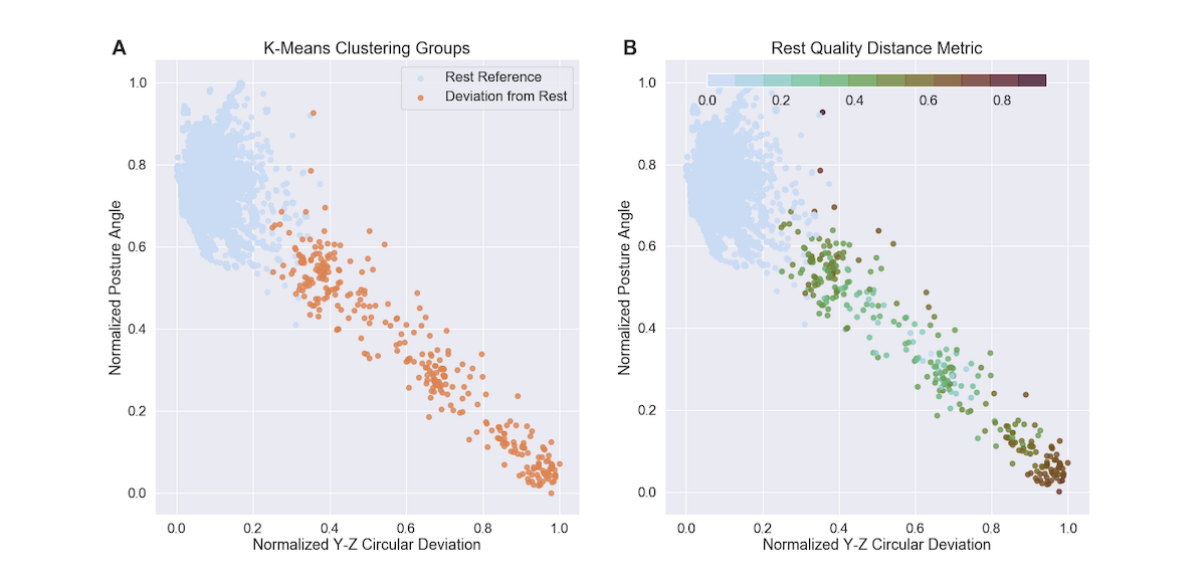
Figure 4. K-means clustering and relative rest quality in a single patient for 2 of the 4 features. (A) K-means clustering diagram plotted across 2 dimensions representing 2 of the 4 features in the clustering algorithm. All data points for each patient were classified using 2 clusters defined as the rest reference cluster (in blue) and the deviation from rest cluster (in orange). (B) Relative rest quality distance metric calculation. A quality of rest metric, represented here by variations in color, was also determined for each data point by calculating the Euclidean distance of the point from the center of the rest reference cluster. All points within the rest reference cluster were assigned a distance of 0. Note that the rest quality color does not have a perfect correlation with apparent distance on this 2D graph because the Euclidean distance is calculated across all 4 feature